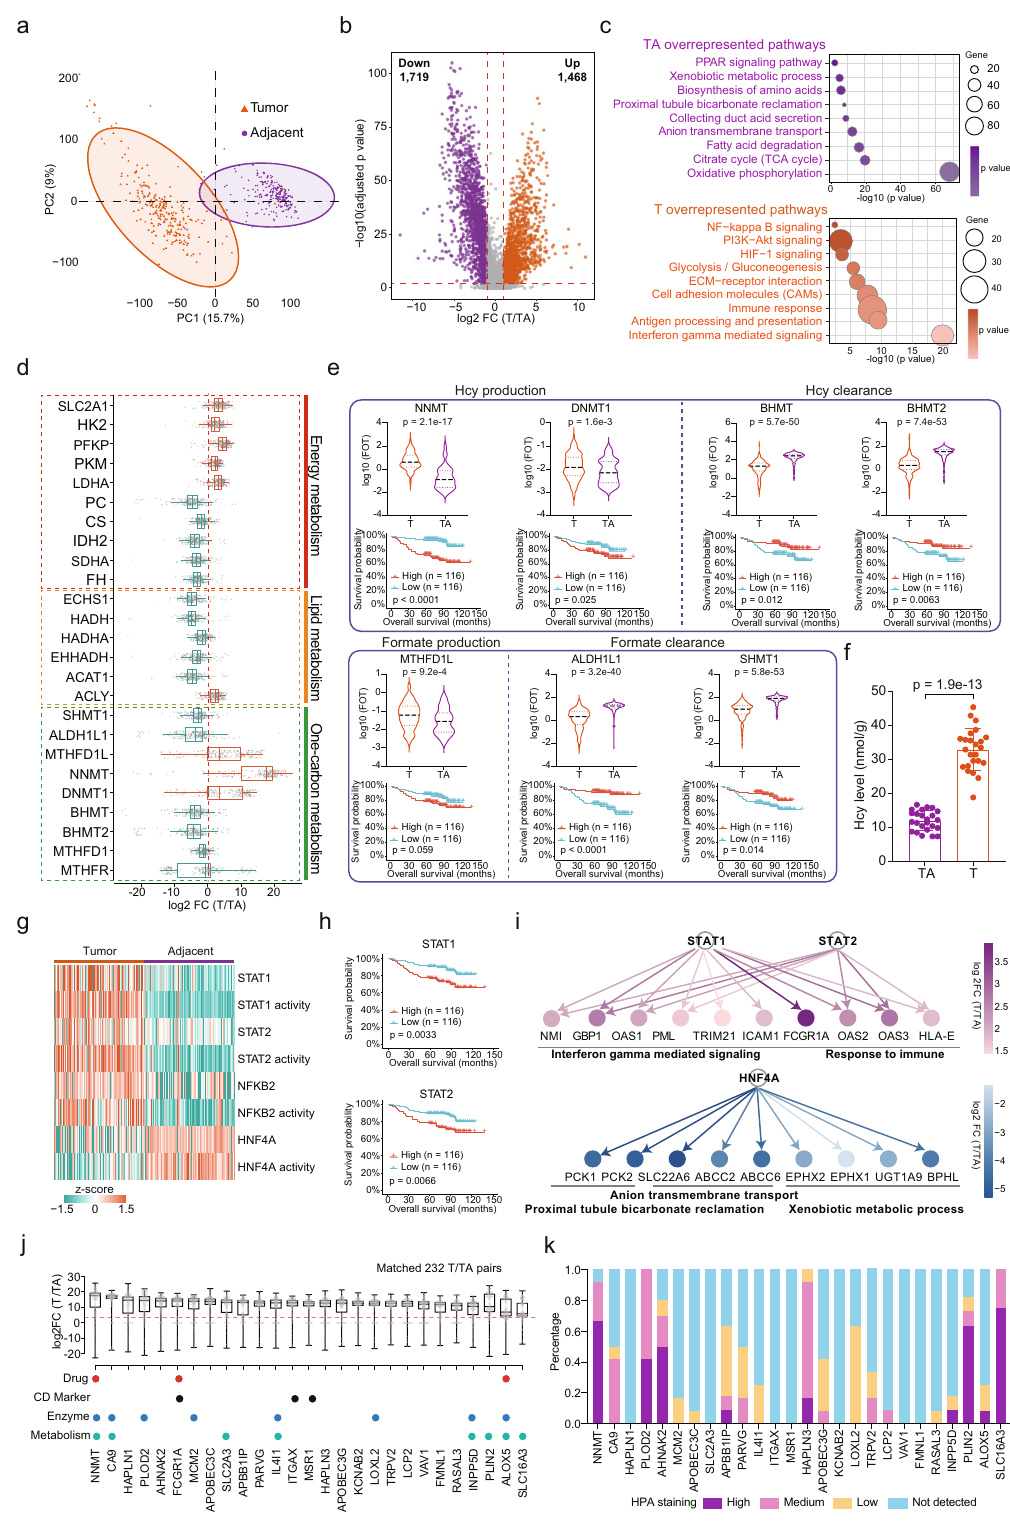
grading were associated with clinical outcomes in this cohort (Supplementary Fig. 5a, b). We conducted separate differential analyses to reveal proteomic differences in different stages and grades. Compared with stages I&II ccRCC, stages III&IV ccRCC displayed elevated expression of complement and coagulation cascades (FGA, PLG), neutrophil degranulation (CEACAM8, CD177), membrane traf fi cking (KIF2A, SRC), and translation